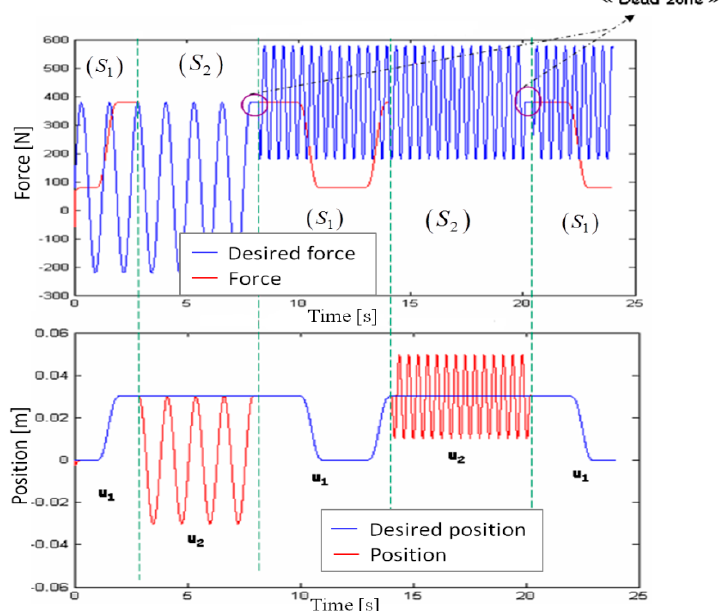
Figure 7. Evolution of the effort ( upper ) and the position ( below ) with their desired trajectories.